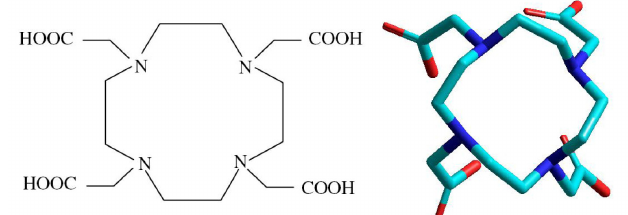
FIGURE 4 - Chemical structure of DOTA and its respective 3D-model extracted from PDB entry code 1NC4 (Corneillie, Fischer, Meares, 2003). The hydrogen atoms are not displayed in the 3D-model. Carbon atoms are shown in light blue, nitrogen in dark blue and oxygen in red.